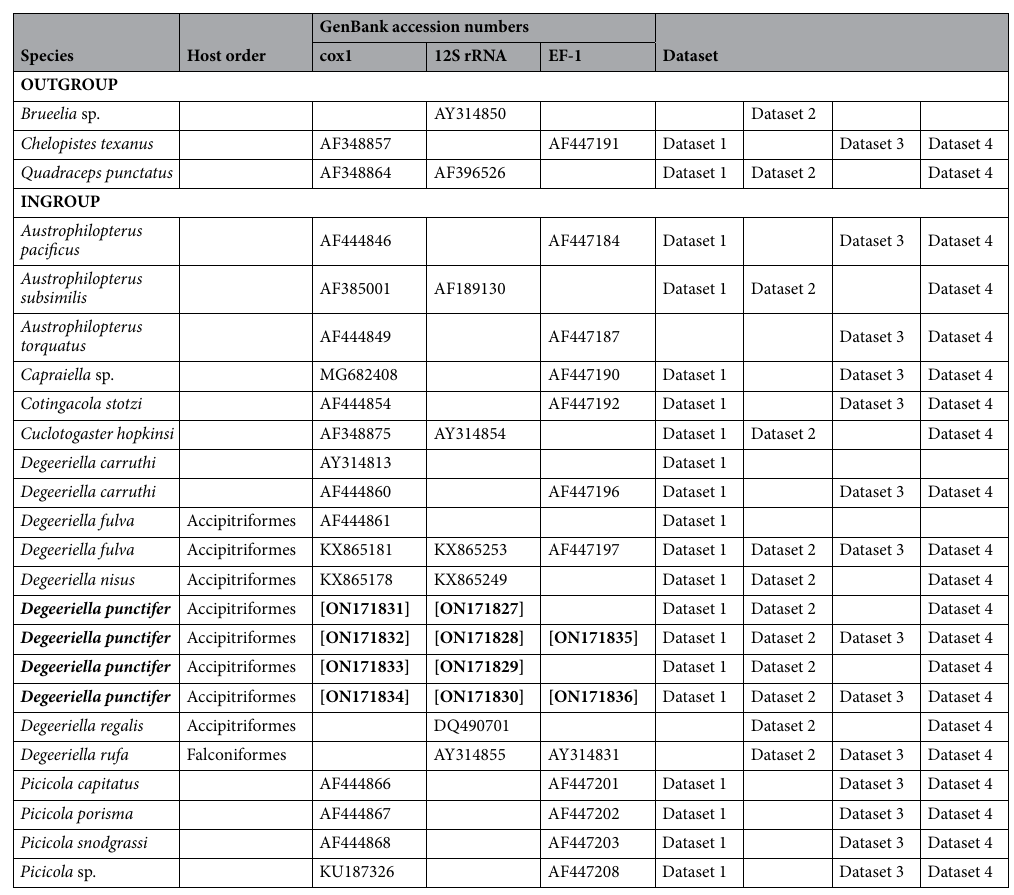
Table 1. GenBank accession numbers of the 12S rRNA , cox1 and EF-1 sequences analysed in this study. The datasets used for the phylogenetic analyses performed in this study are specified. Newly obtained sequences for Degeeriella punctifer are highlighted in